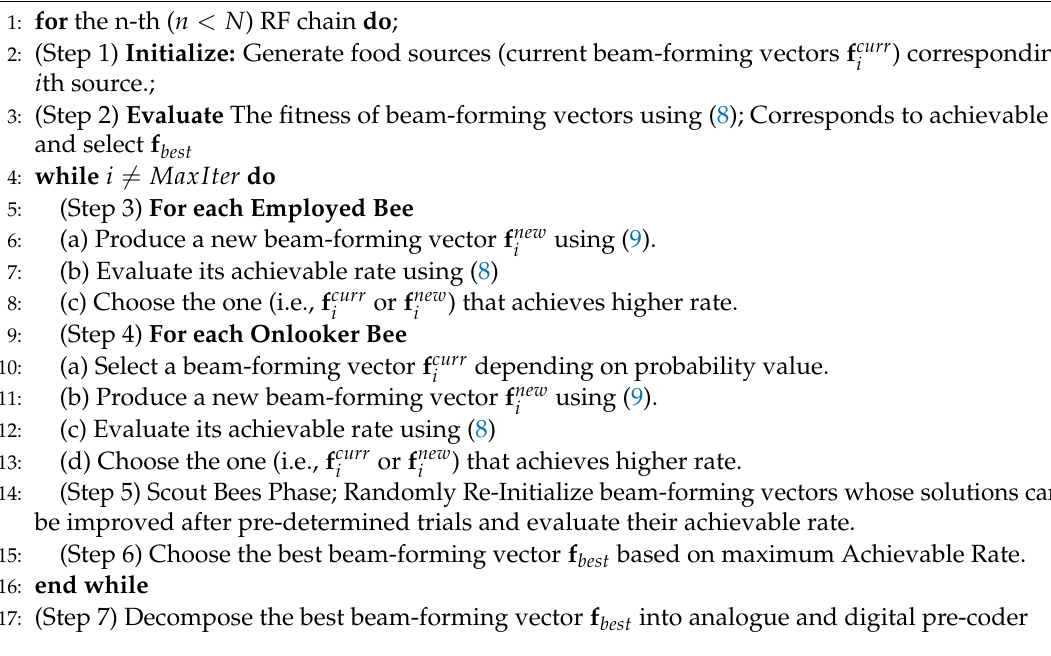
Algorithm 1 Artificial Bee Colony Optimization